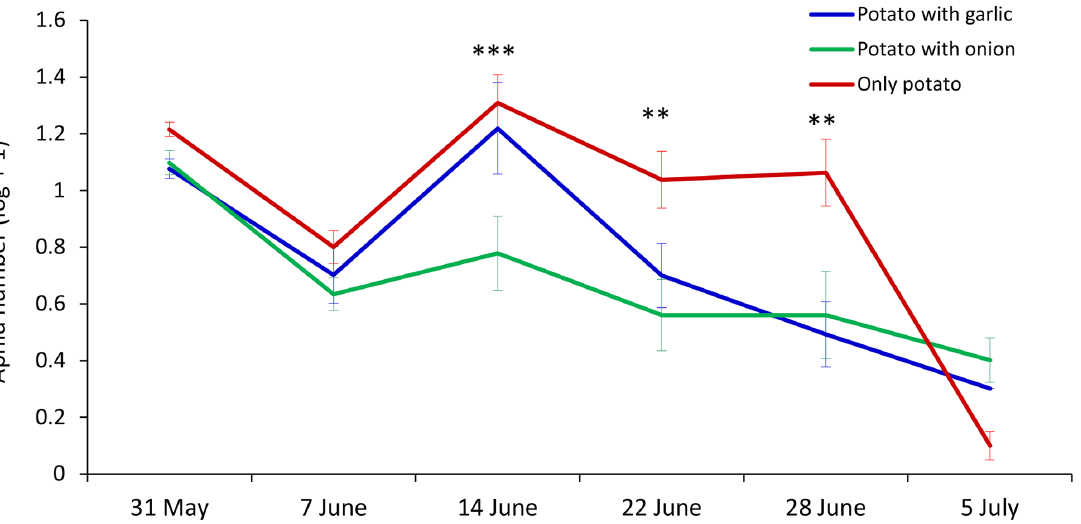
Figure 1. Natural occurrence of winged aphids in intercropped potato with onion and garlic in the field. Mean number of winged Myzus persicae caught in yellow water traps in plots with potato in pure stand, potato intercropped with onion, and potato intercropped with garlic, in a field trial in 2009. Data were transformed as natural logarithms. Error bars indicate 6 SEM. *P # 0.05; **P # 0.01; ***P # 0.001, Tukey HSD test.